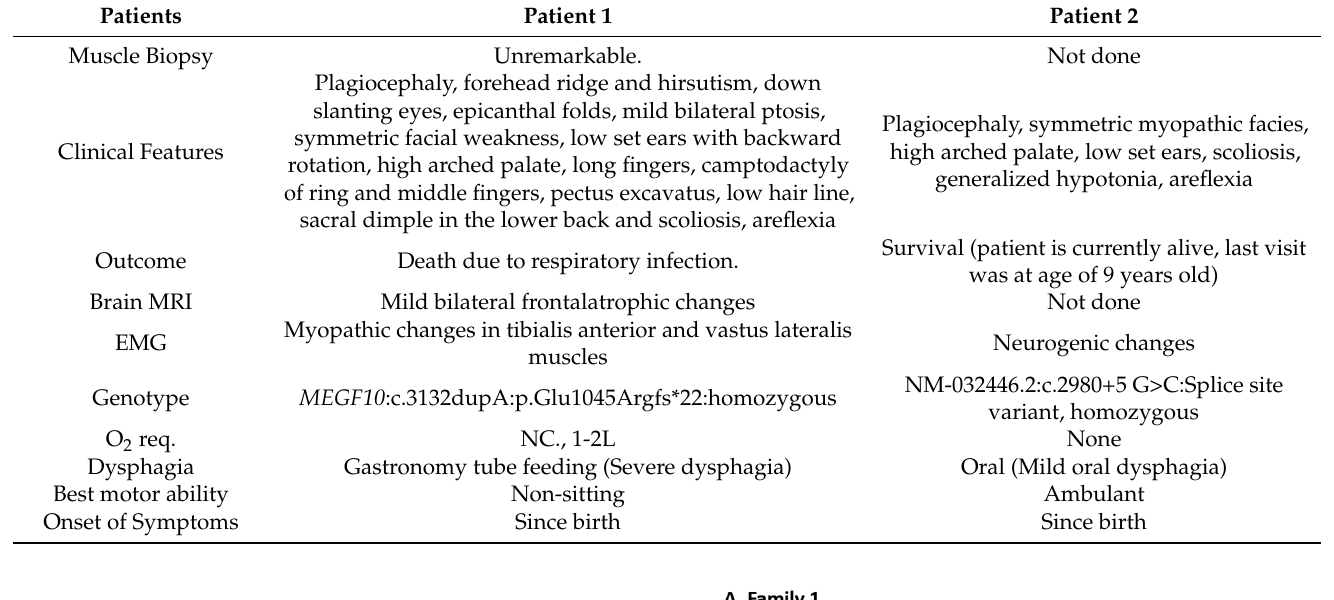
Table 1. Patients’ clinical and genetic features.